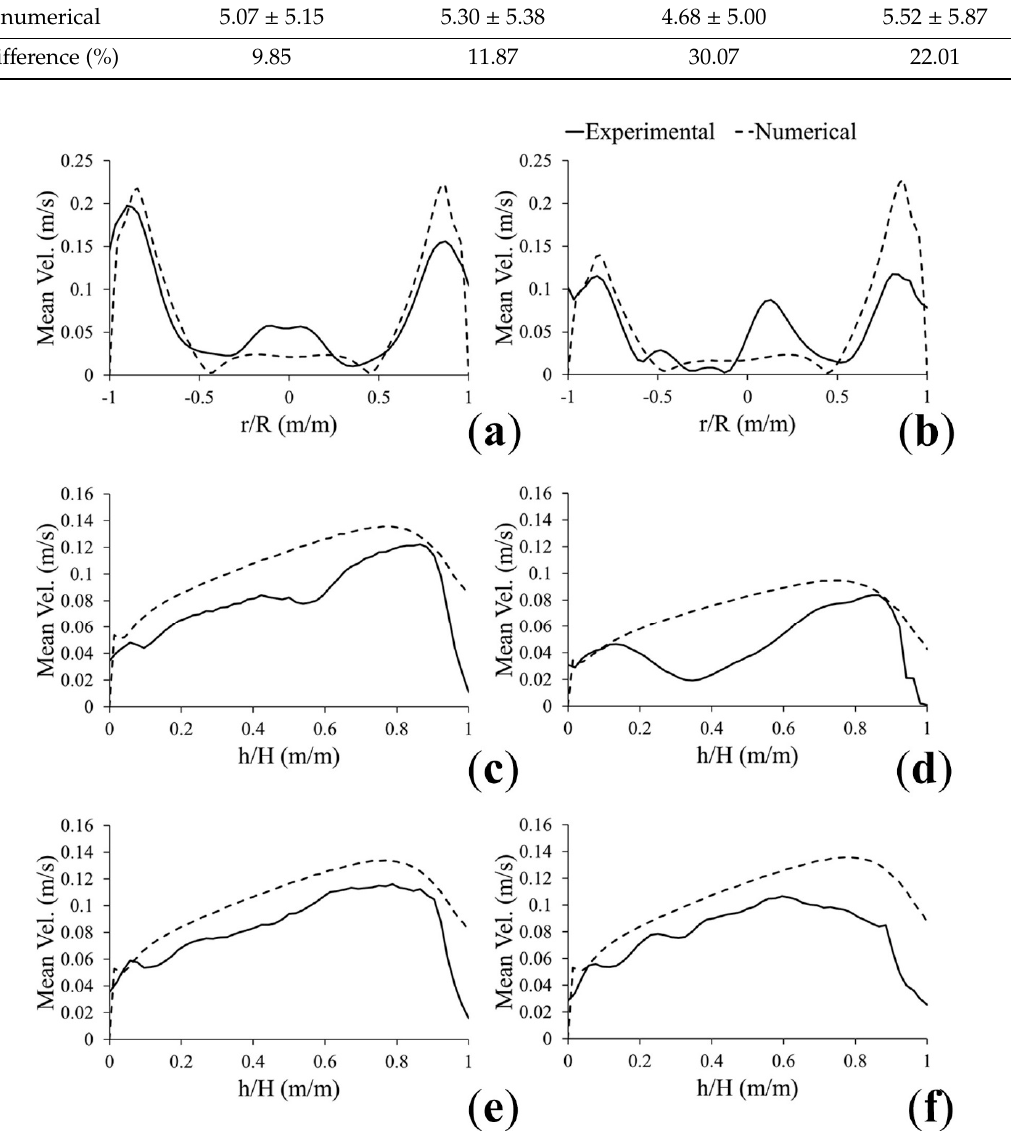
Figure 5. Comparison of experimental (continuous line) and numerical (dotted line) mean velocity radial profiles at h/H = 0.8 for experiments b ( a ) and g ( b ); axial profiles at r/R = − 0.75 for experiments b ( c ) and g ( d ); and axial profiles at r/R = 0.75 for experiments b ( e ) and g ( f ).